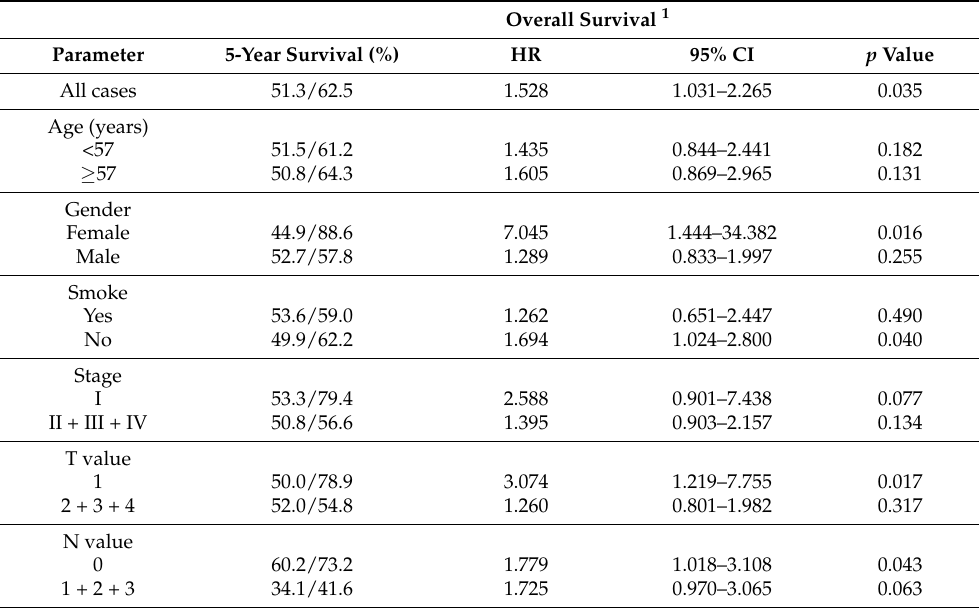
Table 4. Multivariate analysis of the influence of KLF10 expression according to clinical parameters on overall survival in oral cancer